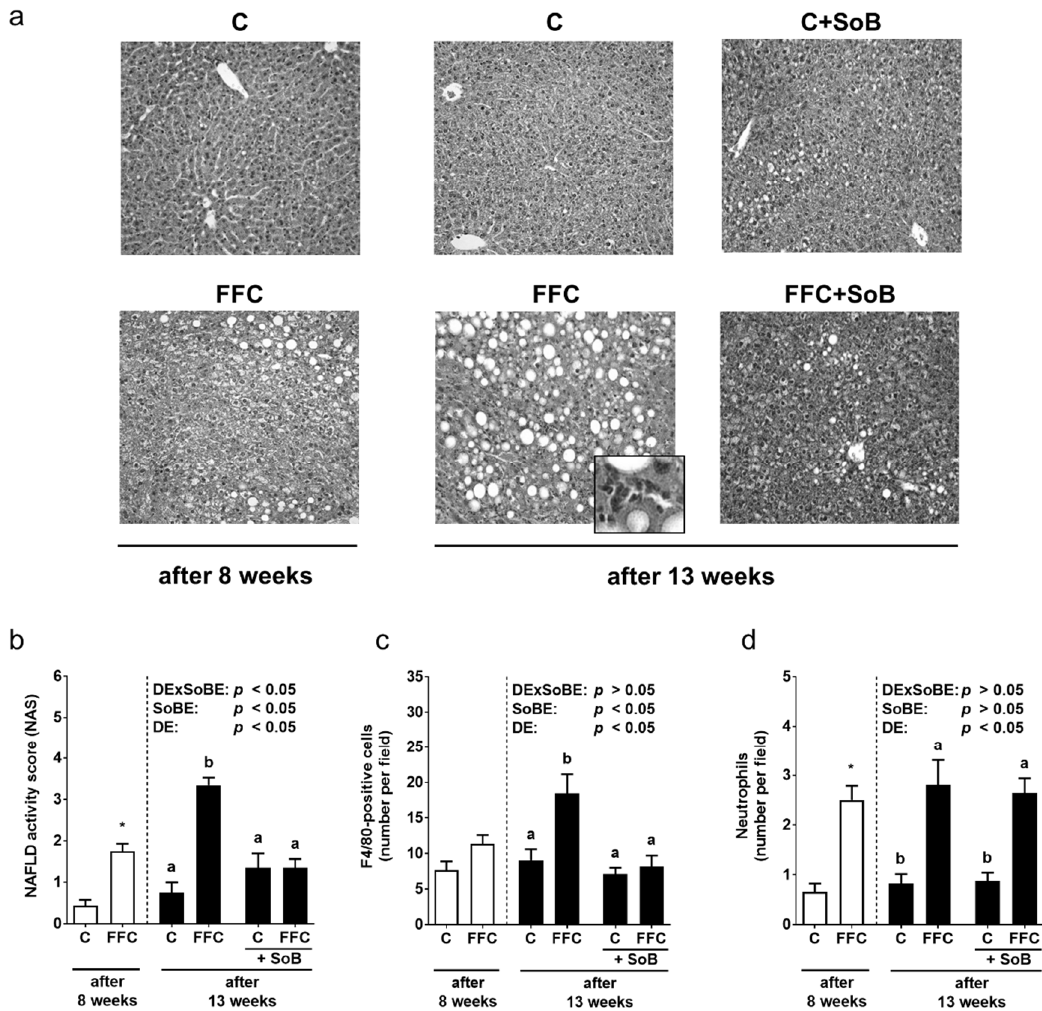
Figure 2. Effect of supplementation of SoB on liver status in mice with FFC-induced NASH. ( a ) Representative photomicrographs of hematoxylin and eosin staining of liver sections (magnification 200 × and 400 × ), ( b ) evaluation of liver damage using a non-alcoholic fatty liver disease activity